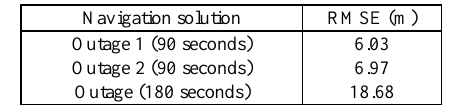
Table 2. Position RMSE for DR navigation solution method based on both CPD heading change and gyroscope for different